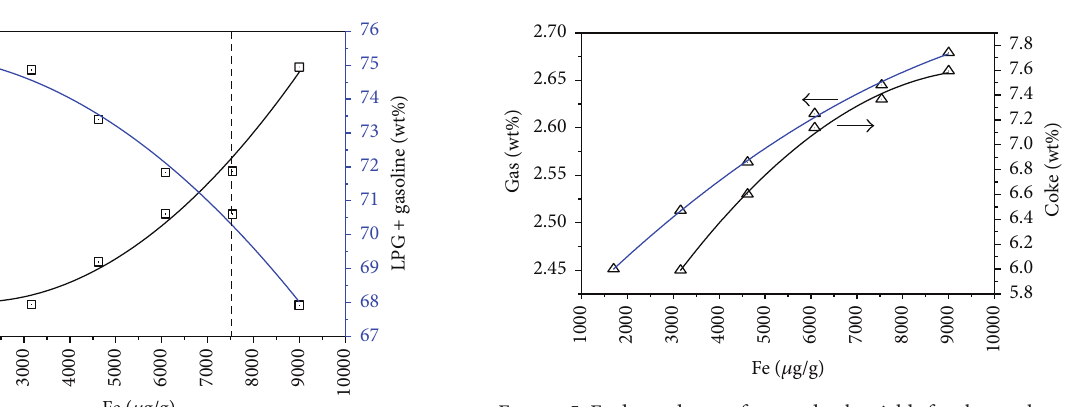
Figure 5: Fe dependence of gas and coke yields for the catalysts.